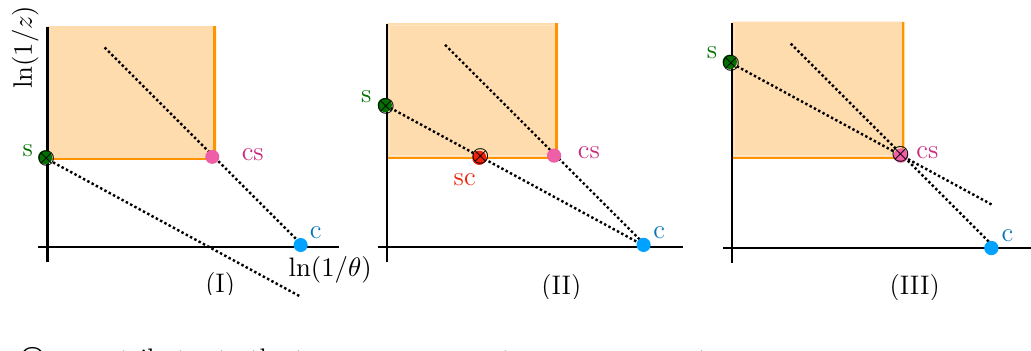
Figure 3 . Three possible hierarchies for q . Shaded region is one that fails Soft-Drop. (I) Largest T Qz cut . The cross section is factorized into 3 function s, cs and c. (II) The soft function s splits q T ∼ into two s and sc.(III) The sc function merges with the cs